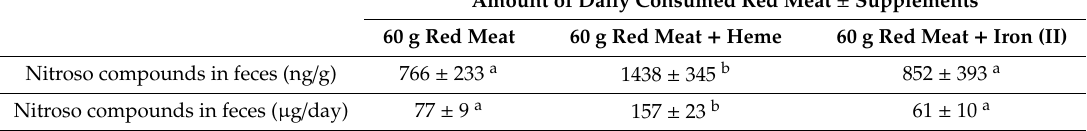
Table 2. E ff ect of heme and iron (II) on the concentration of nitroso compounds in feces (modified from [12]). Amount of Daily Consumed Red Meat ± Supplements 60 g Red Meat 60 g Red Meat + Heme 60 g Red Meat + Iron (II) 766 ± 233 a 1438 ± 345